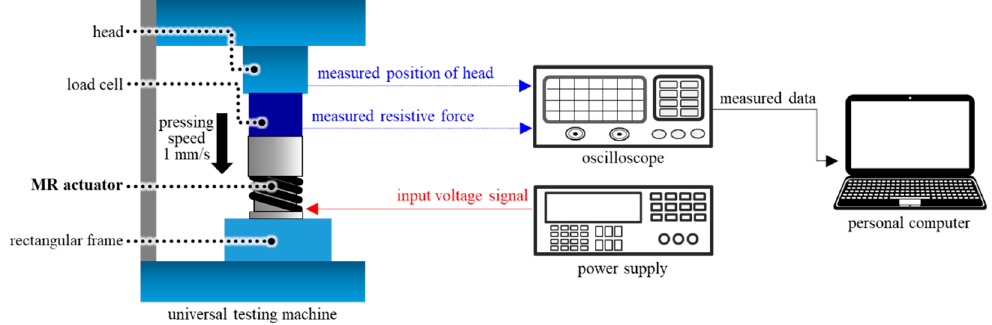
Figure 11. Experimental environment for measuring the haptic performance of a proposed actuator.